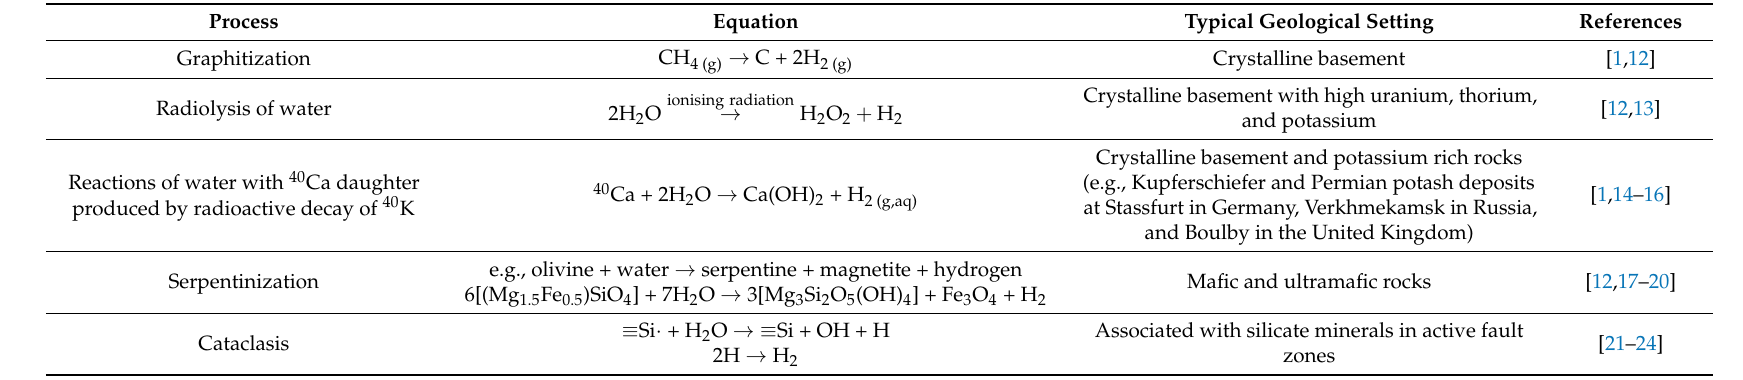
Table 1. Abiotic processes generating